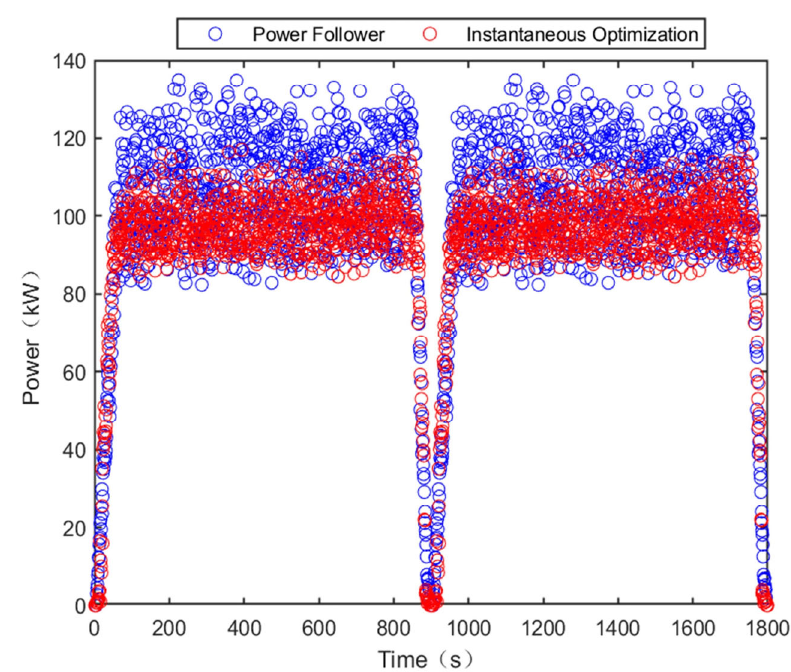
Figure 19. Working power of diesel engine.